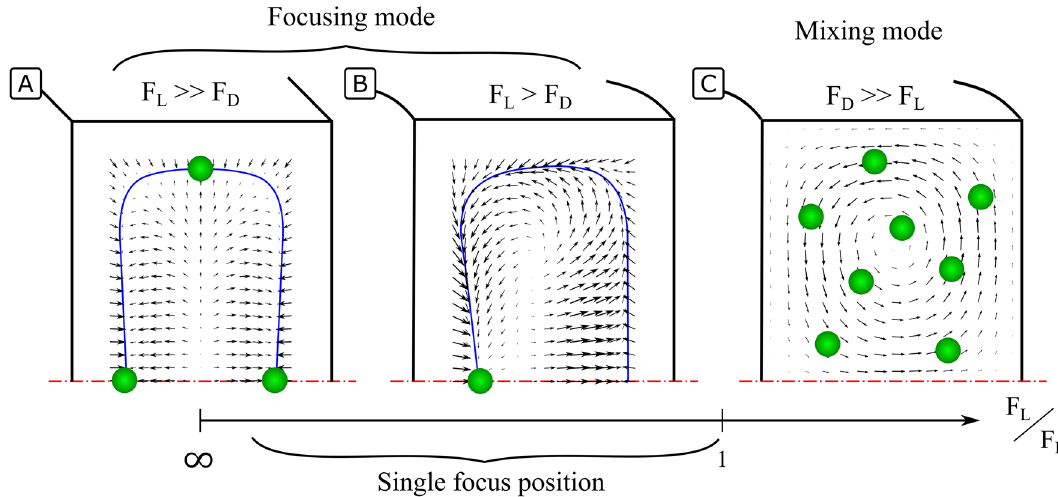
Figure 2. Generic force fields resulting from the combination of F L and F D in inertial focusing systems with high aspect ratio. The equilibrium perimeter (EP) is represented with a blue line. ( A ) Straight system. Only F L is present, leading to four focus positions. ( B ) Curved system where both forces are present and F L > F D . Particles focus into a single position. ( C ) Curved system where both forces are present and F D >> F L . Particles follow the vortexes indefinitely and remain